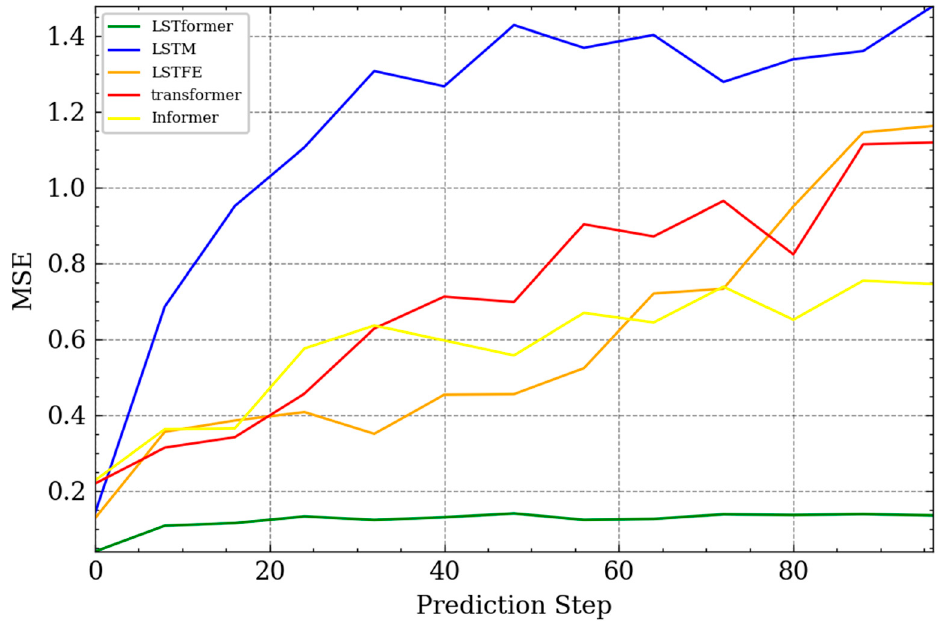
Figure 9. Prediction performance of the different numbers of prediction steps for each model.